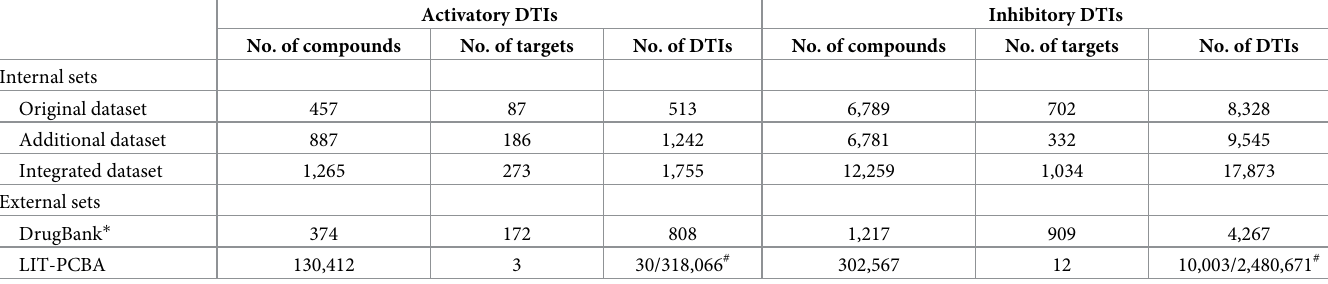
Table 1. Overview of the drug–target interaction dataset for model training and external